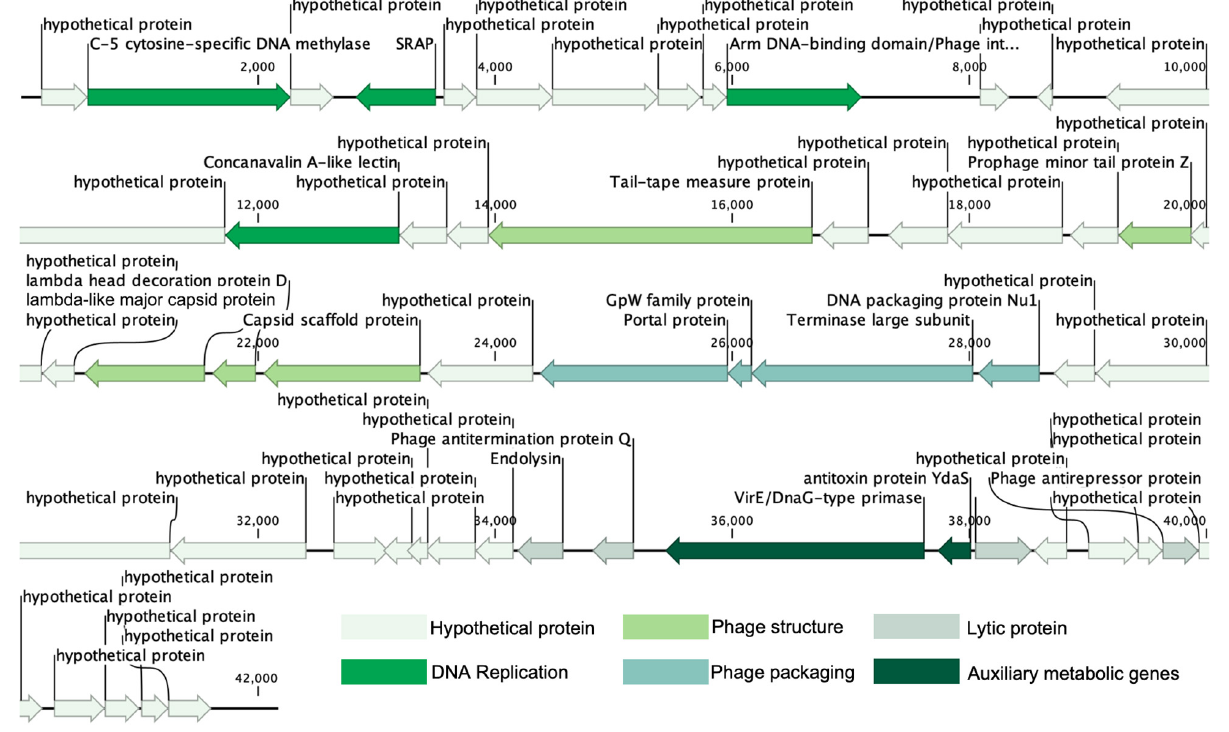
Frontiers in Microbiology |